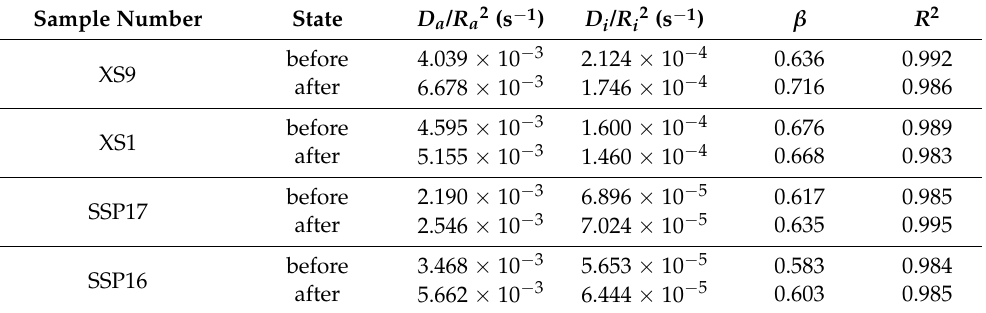
Figure 4. Reproducibility of CH 4 diffusion–adsorption results for SSP16 sample. Table 2. Statistical results of CH 4 diffusion rate.